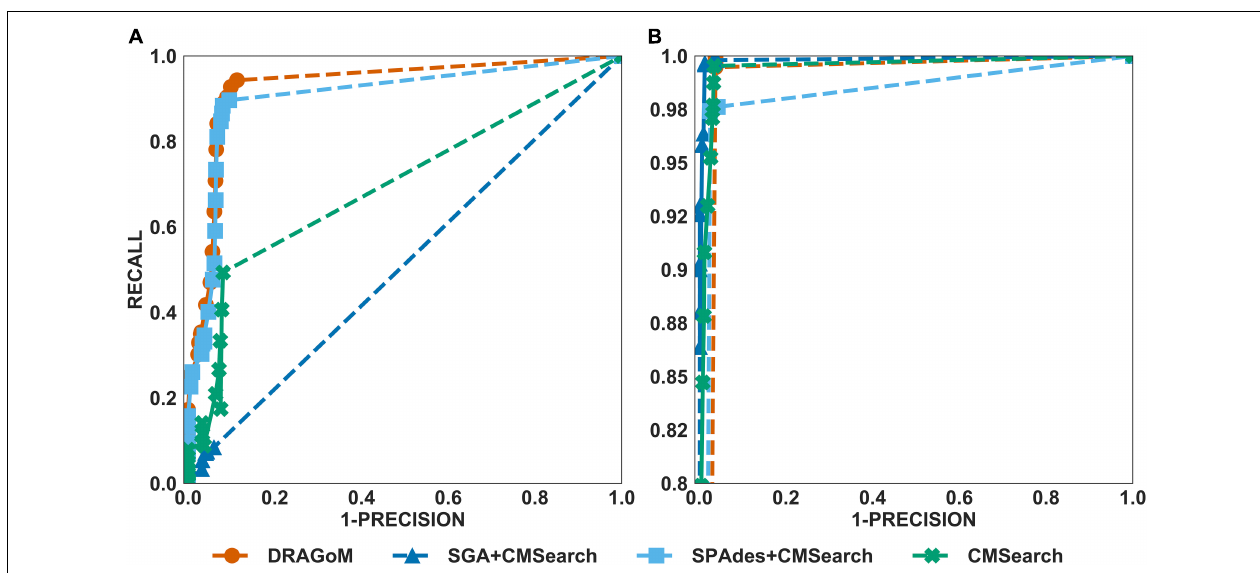
FIGURE 3 | The ROC curves for searching (A) 27 non-16S rRNAncRNA families and (B) 16S rRNAs using the corresponding programs against DS2 (the simulated streptococcus